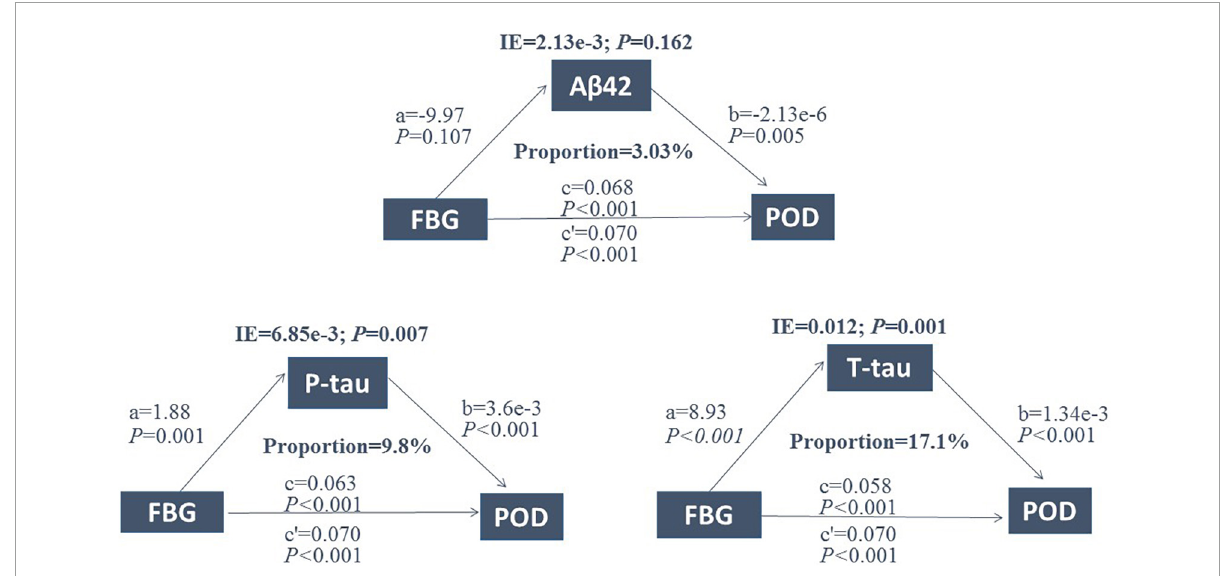
FIGURE4 Mediation analysis. Relationship between FBG and POD was mediated by CSF T-tau (proportion = 17.1%). FBG, fasting blood glucose; POD, postoperative delirium; IE, indirect effect; A β 42, β -amyloid42; T-tau, total tau; P-tau, phosphorylated tau.